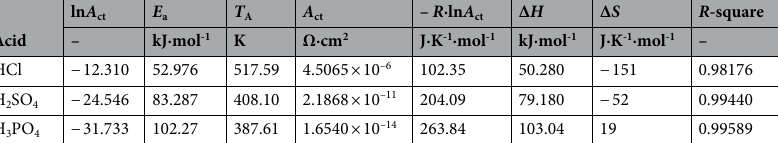
Table 1. Optimal Arrhenius parameters ( Ea and ln A ct ), Arrhenius temperature ( T A = – Ea /( R. ln A ct )), pre- exponential factor ( A ct ), and the entropic factor of Arrhenius – R ·ln( A ct ) from linear regression of Eq. (2). Δ H and Δ S represents, respectively, the activation enthalpy and entropy determined from polarization and impedance measurements in previous work 21